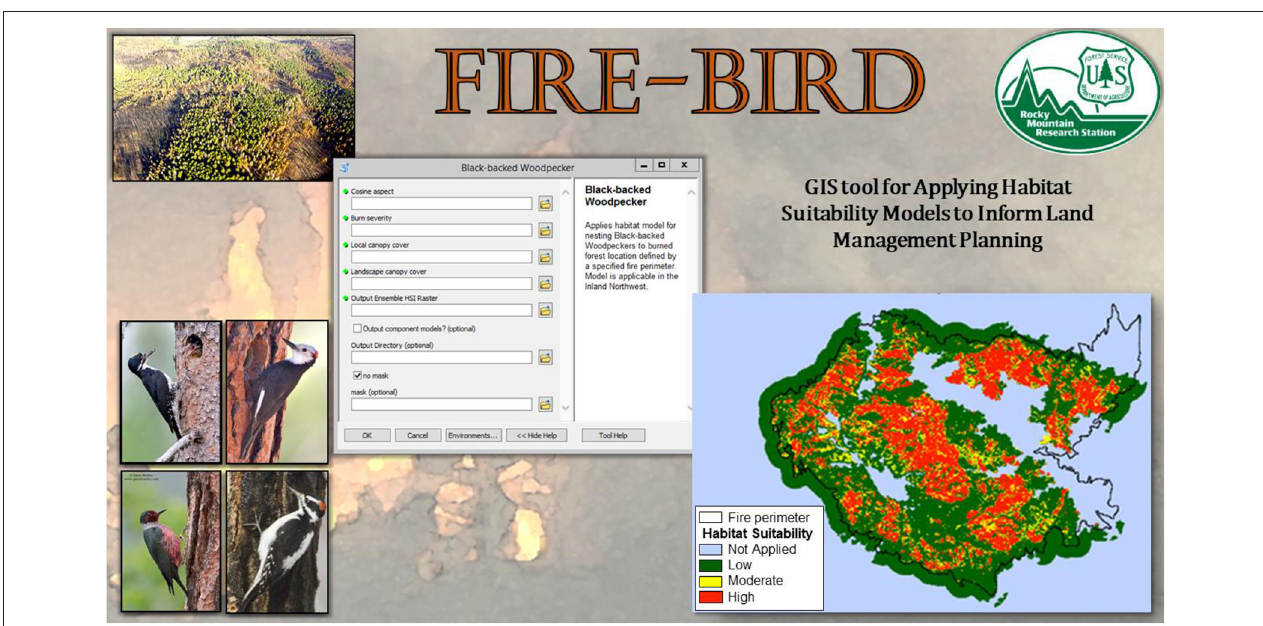
FIGURE 5 | Optimizing ecological services in recently burned forests. Removal of burned or beetle-killed trees through salvage logging can provide economic value to local communities and reduce snag hazards. However, removal of snags following recent wildfire or beetle outbreaks has negative ecological consequences, including reduction of habitat for disturbance-associated wildlife species. Consequently, forest managers are challenged with implementing post-disturbance management projects while concurrently meeting the requirements of existing laws and planning directives to maintain wildlife habitat for disturbance-associated species. Salvage logging is often litigated over concerns regarding negative effects on aquatic and terrestrial ecosystems, and on wildlife associated with recent disturbance (e.g., Lindenmayer and Noss, 2006; Saab et al., 2009; Hutto et al., 2016). Several woodpecker species of conservation concern (SCC; black-backed woodpecker [ Picoides arcticus ], white-headed woodpecker [ Dryobates albolarvatus ], Lewis’s woodpecker [ Melanerpes lewisii ]), and American three-toed woodpecker [ Picoides dorsalis ] are strongly associated with recently burned or beetle-killed forests because forest openings and snags provide critical nesting, perching, and foraging resources. Habitat suitability index (HSI) models for these woodpeckers were developed from nest location and associated environmental variables (Saab et al., 2011, 2019; Latif et al., 2013, 2015, 2020) to map habitat for wildlife. A GIS decision-support tool (FIRE-BIRD) provides habitat suitability maps that inform treatment designs to maximize habitat suitability and minimize negative effects to woodpecker SCC for a single fire or proposed management activity, while accounting for overall habitat in a surrounding national forest ( Latif et al., 2018). This information allows maximization of ecosystem services by allowing areas to be harvested with minimal impacts on